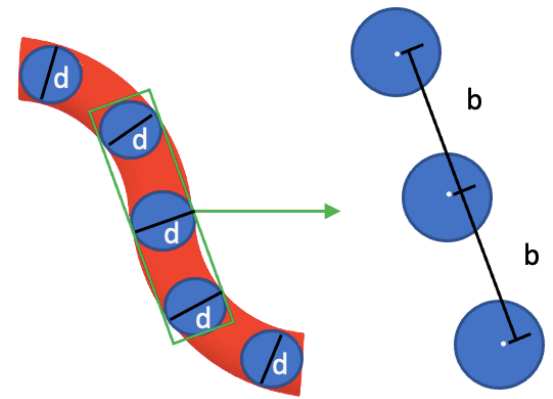
Figure 2. Conformation of chain beads representing an actin filament where external forces and an electric field applied to beads form an arbitrary distribution of bending and structural conformations. The distance between beads is defined as the parameter b, as seen on the right side of the image. The chain of beads is under the effect of an electric field represented by ‘E’.